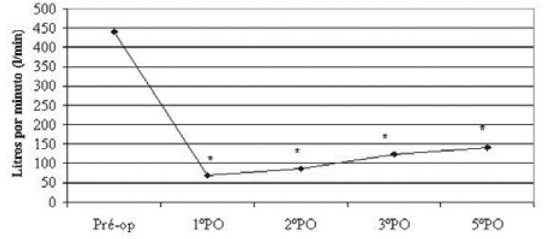
Fig. 1 - Valores médios diários de pico de fluxo expiratório.